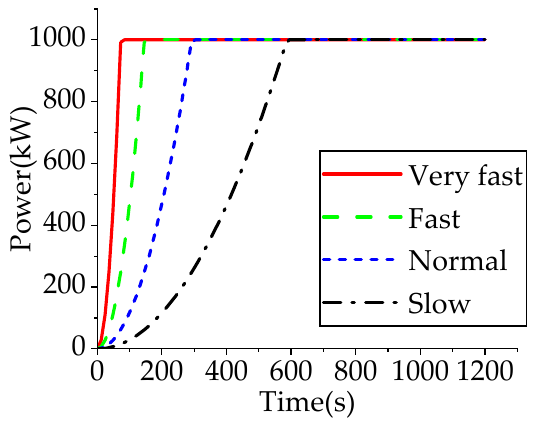
Figure 3. Power of the fire.